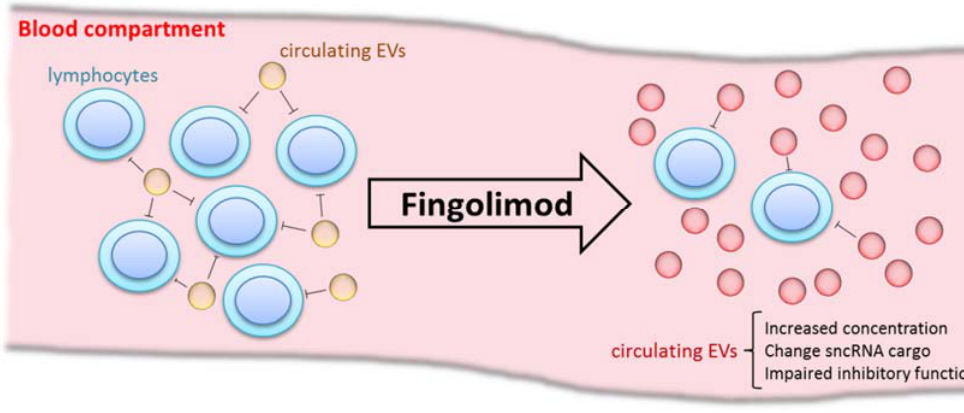
Figure 7. Fingolimod modulates the release and regulatory function of EVs. Before fingolimod (FGM) treatment, lymphocytes circulate freely in the blood stream, maintaining a proinflammatory status that is characteristic of MS. Besides, EV concentration is low even though they have a high immune regulatory function, probably in order to counteract proinflammatory status. After first dose intake of FGM, this scenario changes; lymphocytes are arrested in lymph nodes, conditioning a low inflammatory status and thus the EVs released change to a low regulatory profile according to the circulating microenvironment.